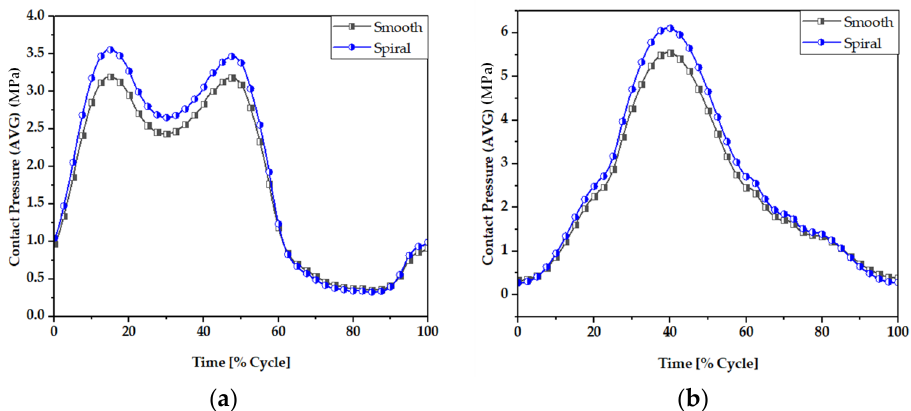
Figure 8. Average contact pressure (MPa) of smooth and spiral head-neck tapered joints during ( a ) walking and ( b ) jogging loading conditions.